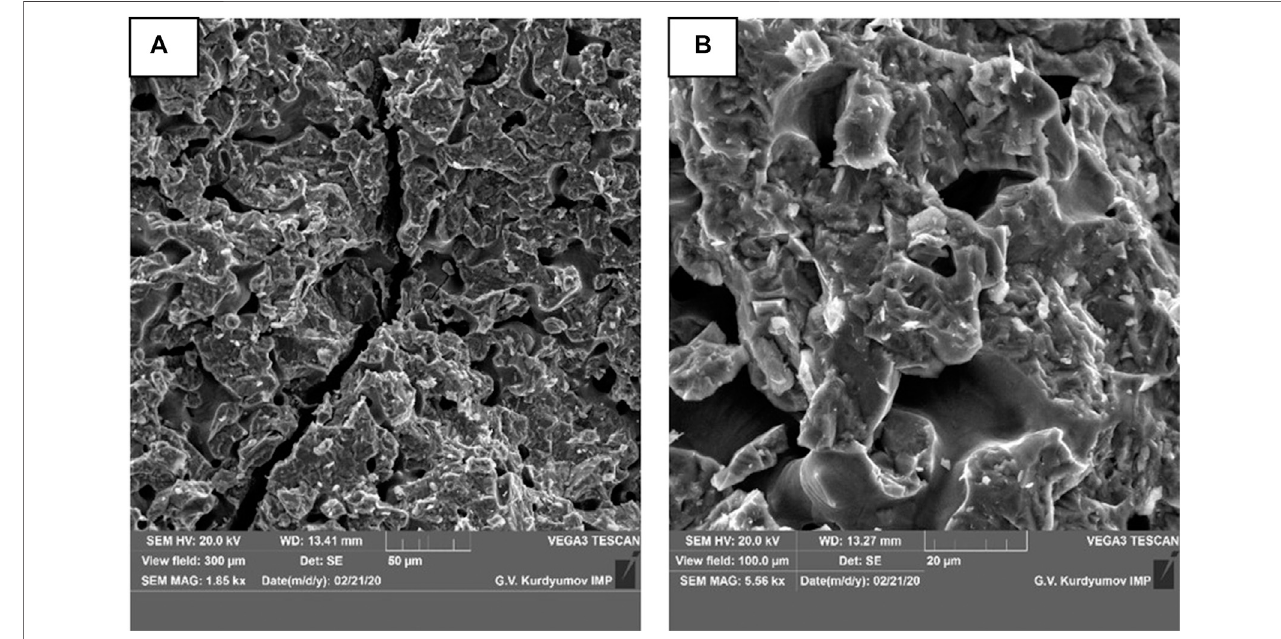
FIGURE 5 | SEM images of bulk sintered samples after